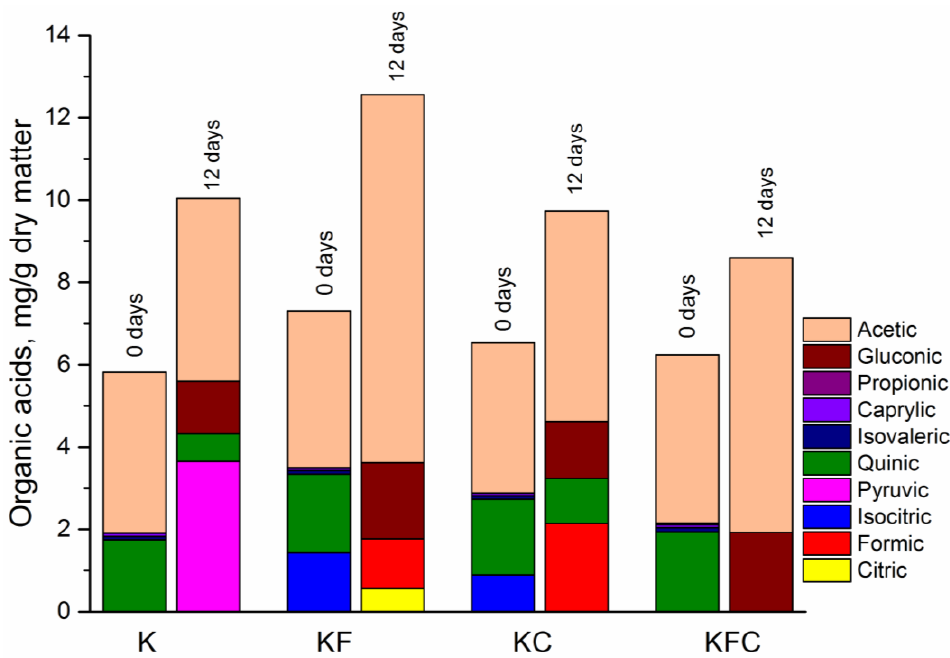
Figure 5. Organic acids content in the kombucha samples at 0 and 12 days of fermentation (K— control, KF—kombucha with algae extract, KC—kombucha with lichen extract, KFC—kombucha with a mixture of algae and lichen extracts).